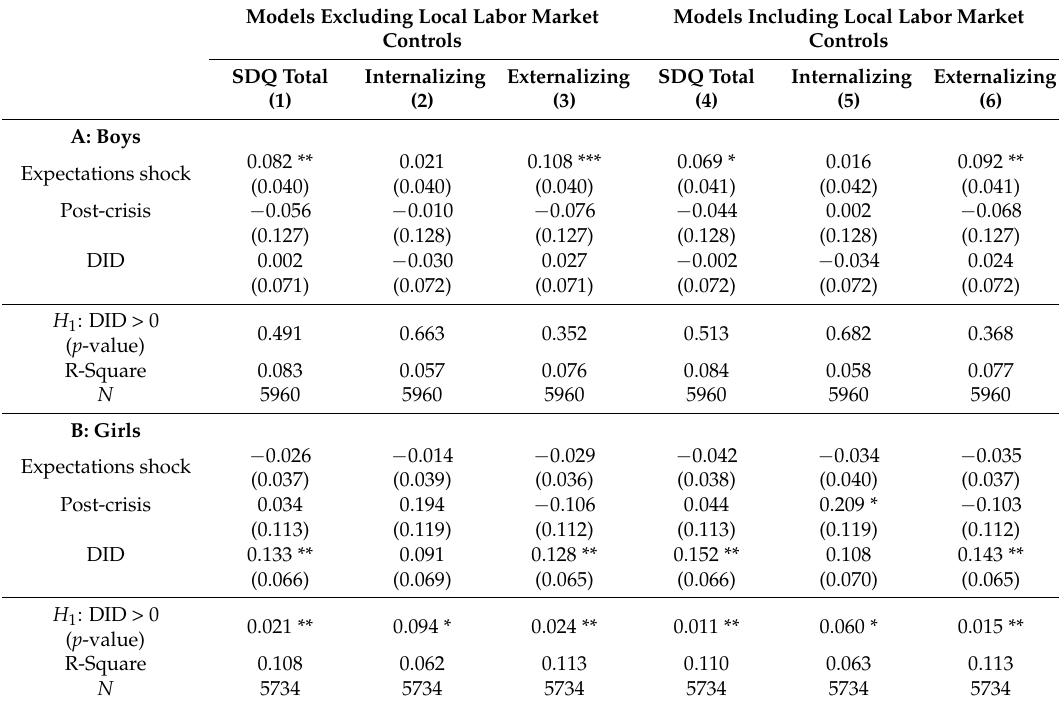
Table 1. The effects of unemployment expectations shocks (top 25th percentile) on parent-rated SDQ outcomes, separately for boys and